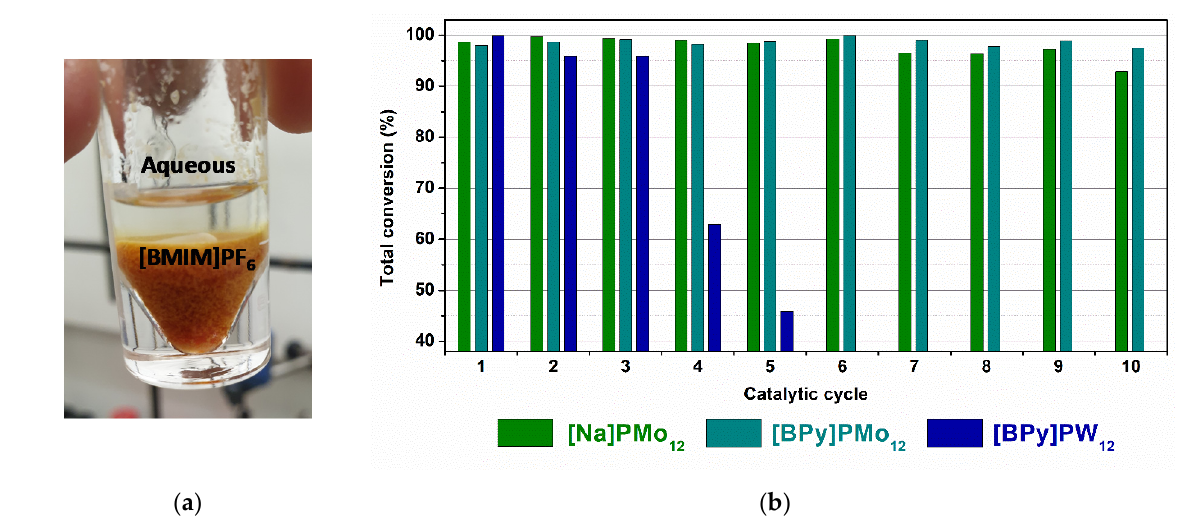
Figure 4 . ( a ) Representation of the [Na]PMo 12 /[BMIM]PF 6 system after ten consecutive ODS/ODS cycles. ( b ) Combined desulfurization/denitrogenation efficiency obtained after 1 h of reaction, when catalyst/[BMIM]PF 6 system is reused for ten consecutive cycles, using catalysts [Na]PMo 12 , [BPy]PMo 12 , and [BPy]PW 12 , with H 2 O 2 as oxidant, at 70 °C .